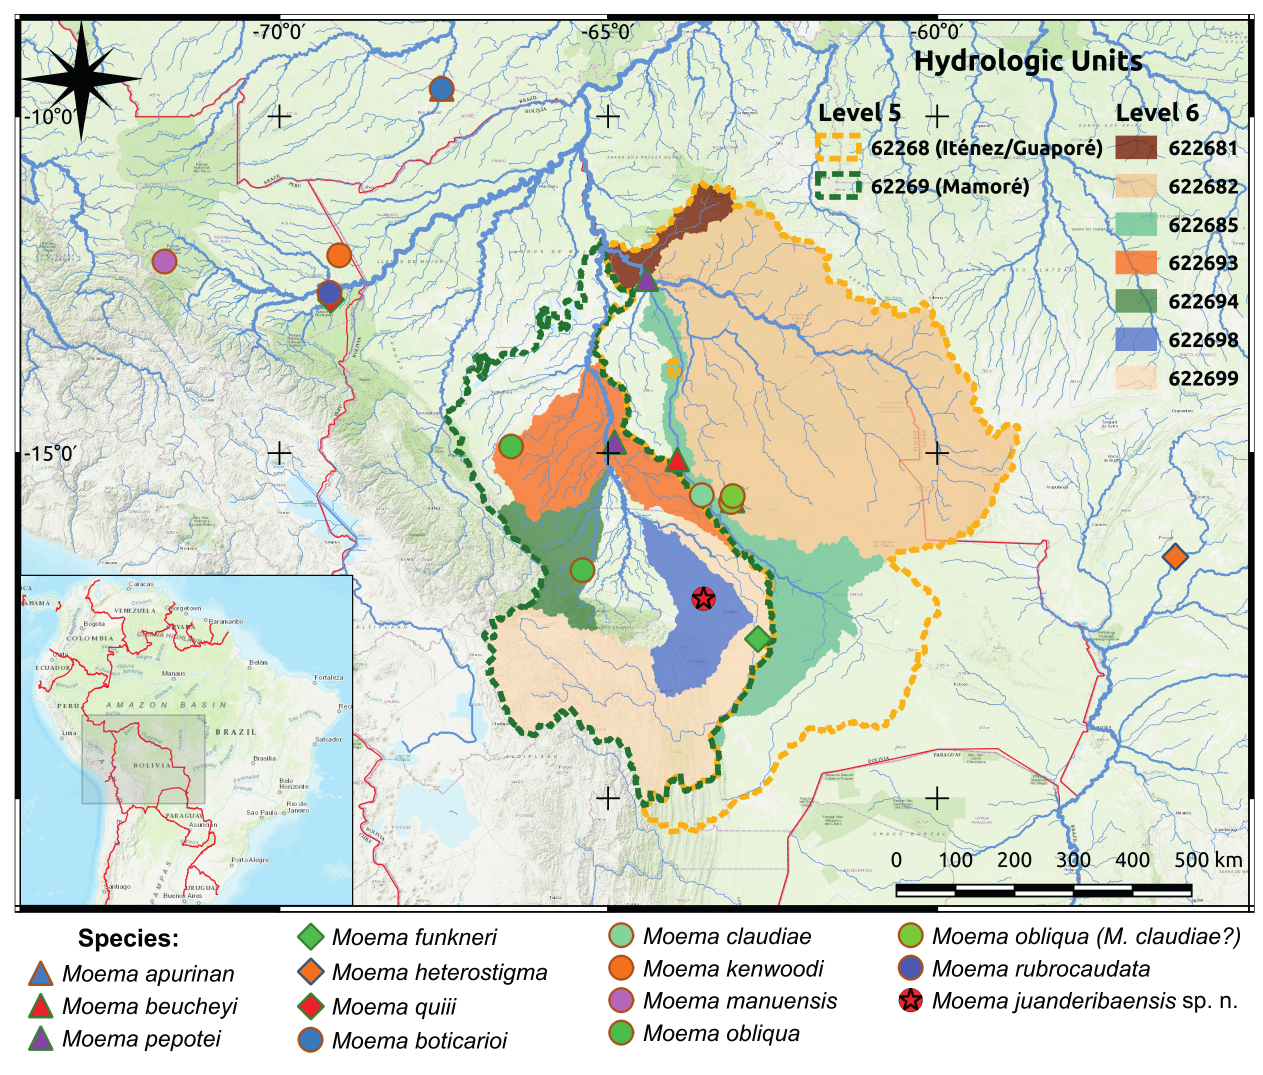
FIGURE 6 | Occurrence localities of Moema species in Bolivia and surroundings. Sources: Hydrologic Units from Lehner, Grill (2013); Basemap ESRI World Topo